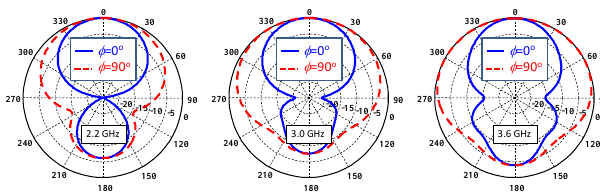
Figure 2: The simulated return loss characteristics of the design steps.